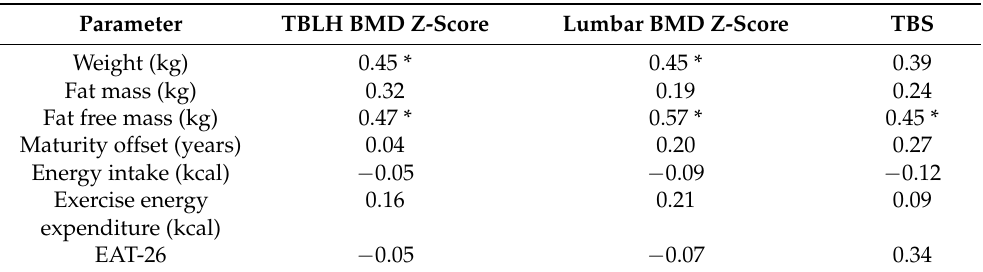
Table 3. Correlation coefficients of bone parameters, physical characteristics, and energy parameters ( n =